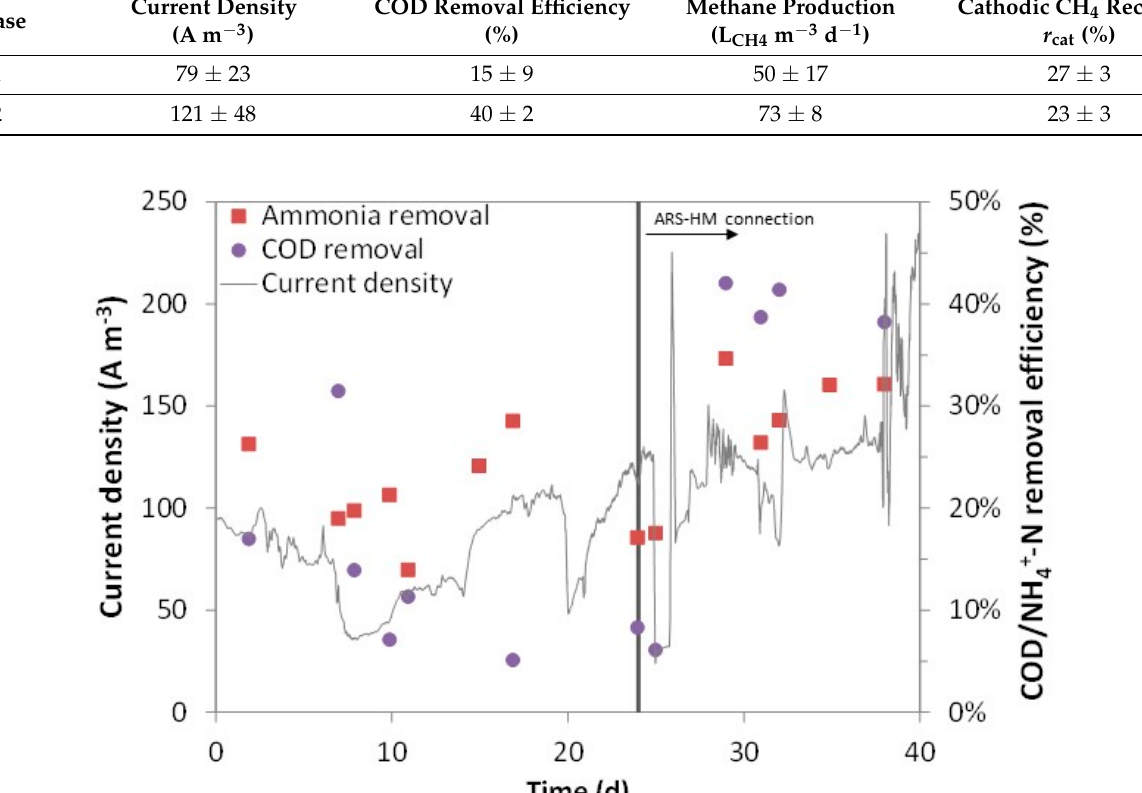
Table 2. Average values for the main performance parameters of the MEC related to methane production. Phase